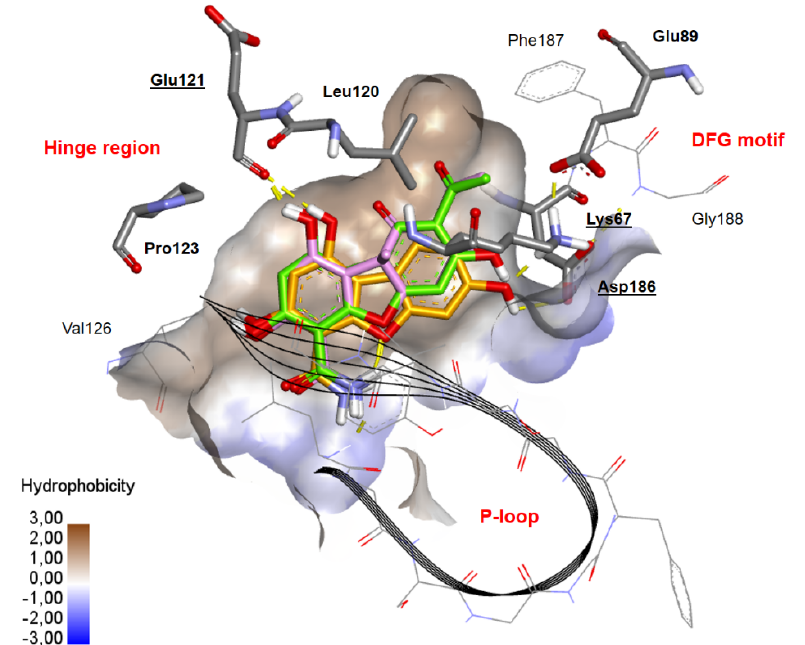
Figure 3. Binding pose found by the docking program GOLD for compound 44 (orange), compound 43 (green), and cercosporamide (pink) within the ATP pocket of Pim-1 (PDB ID 3A99). Hydrogen bonds are indicated as yellow lines.